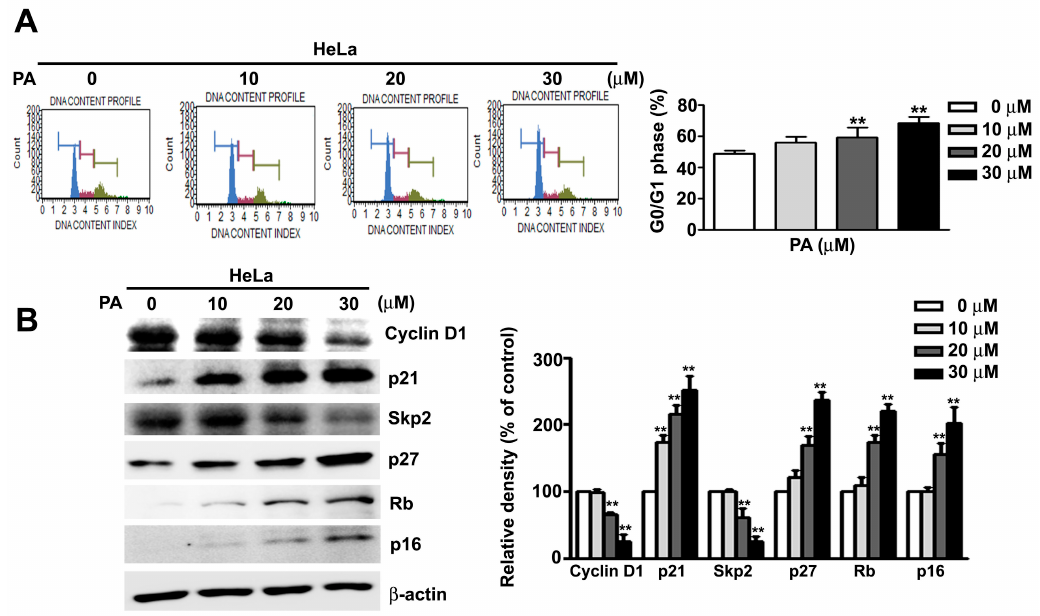
Figure 2. Effect of PA on cell cycle regulation in HeLa cells. ( A ) Cells were treated with various concentrations of PA (0 to 30 μ M) and cell cycle progression was measured by flow cytometry; ( B ) expression of proteins that regulate the cell cycle were measured after treatment of cells with various concentrations of PA (0 to 30 μ M) for 24 h. Values are means and standard errors of 3 replicates, ** indicates p < 0.01 versus control.